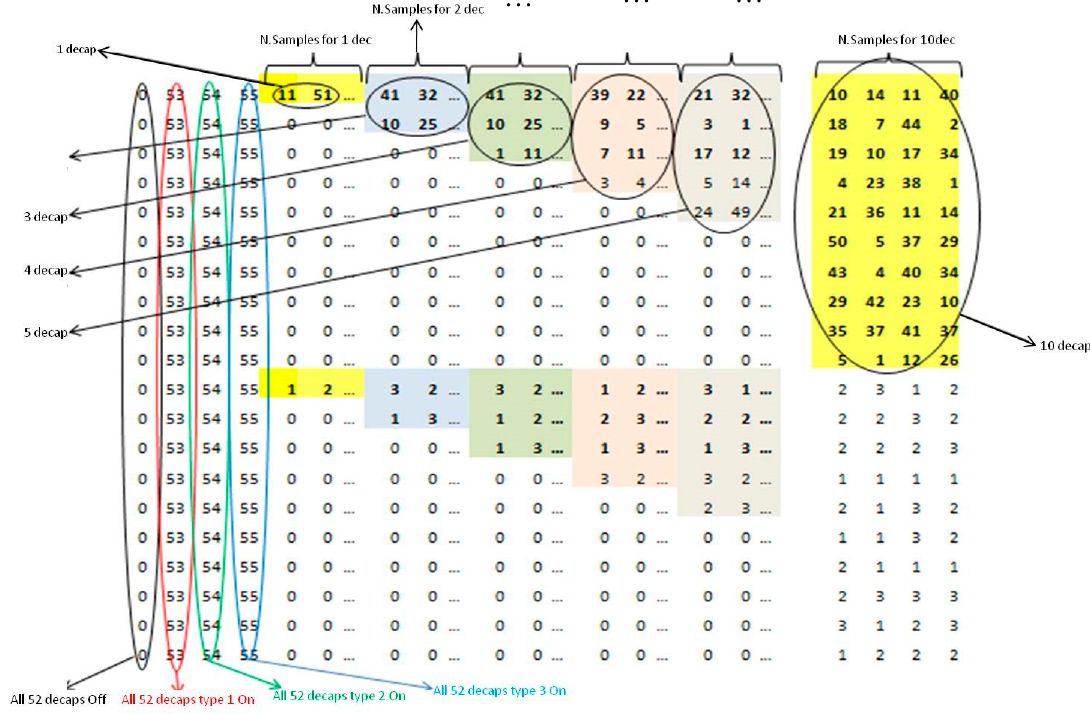
Figure 5. TS for one of the ports (Port 1).